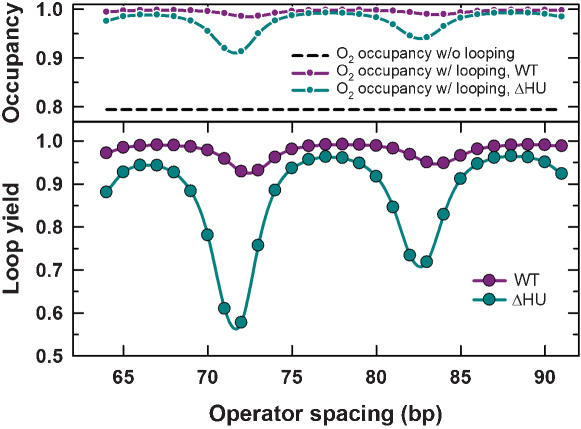
Predicted repressor occupancy of the primary operator and loop yield as a function of operator spacing corresponding to the data of Becker et al.
[19]. Upper panel: the proportion of the primary operator site (O2) bound by LacR for wild-type and HU-deletion strains computed from their respective best-fit parameters using formula 1−Eloop (see Equation 13). The occupancy of the primary operator in the absence of the looping contribution is shown for reference (dashed line). Lower panel: the loop yield computed using Equation 10 for both wild-type and HU-deletion strains. J values used in these calculations are those given in Figure 6.